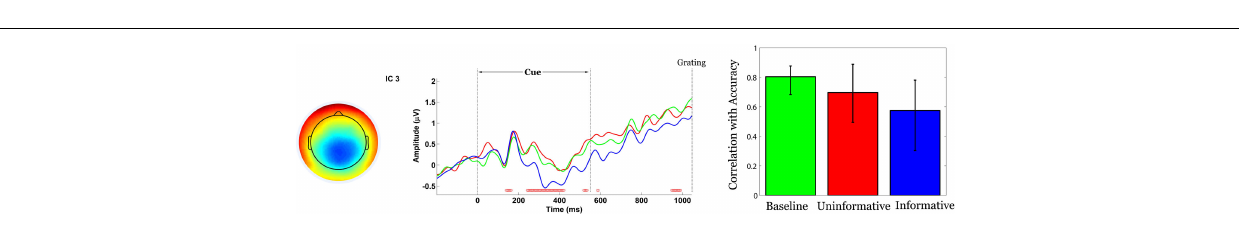
FIGURE 8 | Brain-behaviour relationships (Behaviour ST-PLS). Left: colour- coded topomap of component 3 indicates the weights in the ICA mixing matrix. Warmer colours represent positive weights. Middle: condition-specifi c component activation time-locked to cue onset. Green, red and blue lines